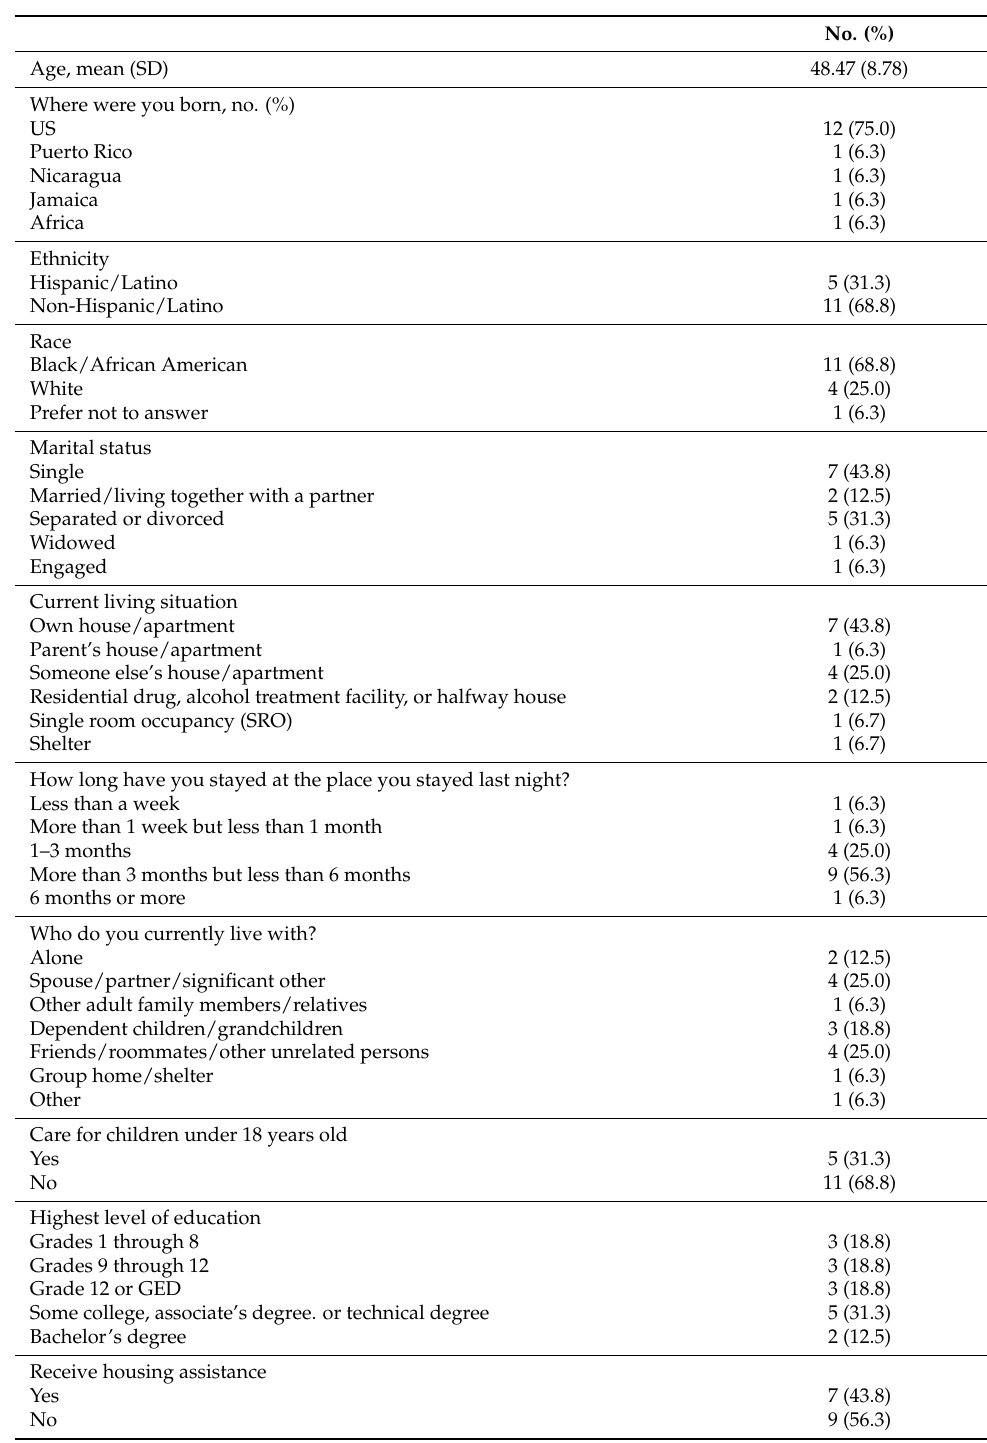
Table 2. Demographic and housing characteristics of participants ( n =